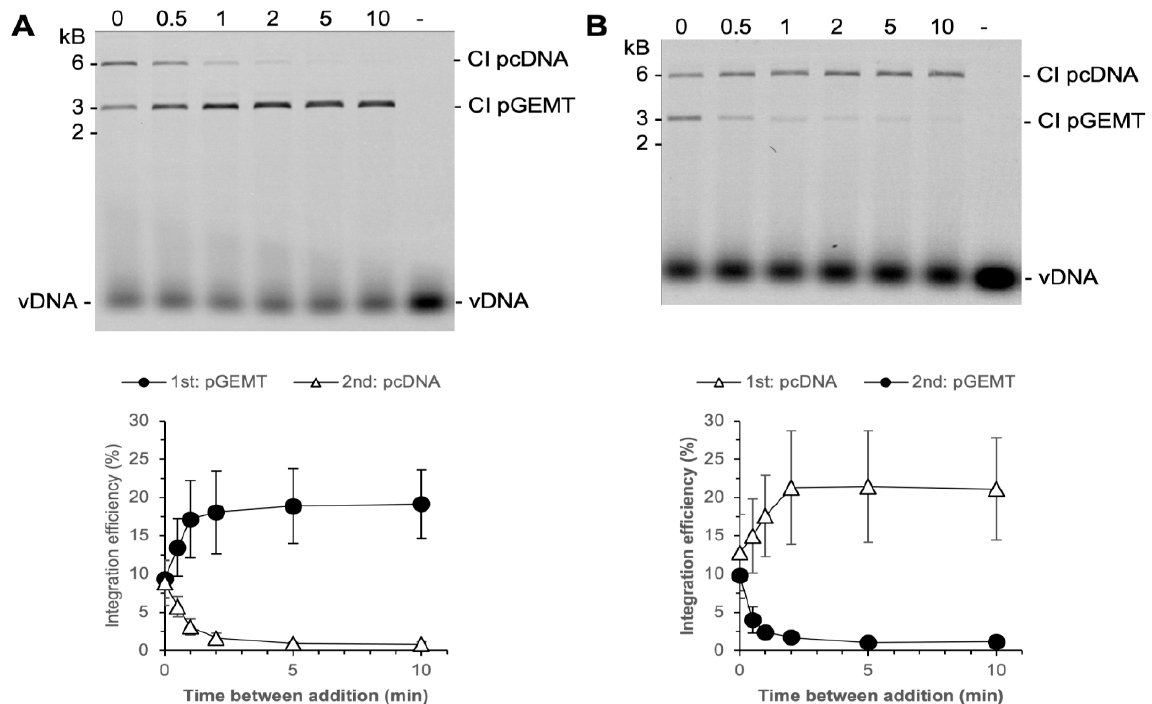
Figure 7. PFV intasomes do not commit early to target DNA. Integration reactions were performed with a 3 kb and a 6 kb plasmid. Reactions were started with one plasmid and a second plasmid added at variable time later. The zero time point represents plasmids added simultaneously to the reaction. ( A ) The 3 kb plasmid was added first and the 6 kb plasmid added second; ( B ) the 6 kb plasmid was added first and the 3 kb plasmid was added second. The total Cy5 fluorescence in each lane was quantified and each integration product calculated as the fraction of the total fluorescence (bottom). The average of three independent experiments with at least two independent intasomes preparations is shown. Error bars indicate the standard deviation.